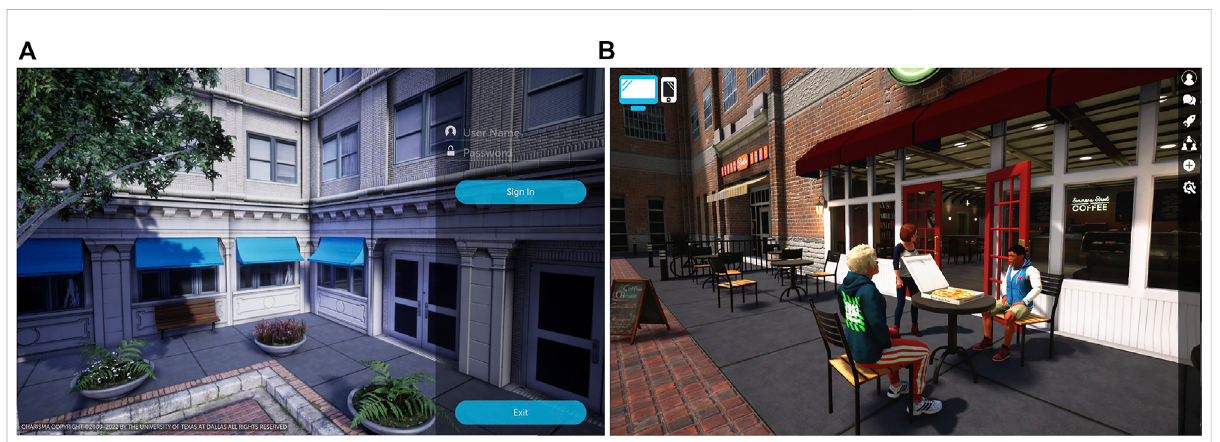
FIGURE 3 Charisma 1.0 virtual world. (A) Participants used a personalized login code to sign into the virtual training platform (B) Participants used their avatar to interact with clinician and faux friend